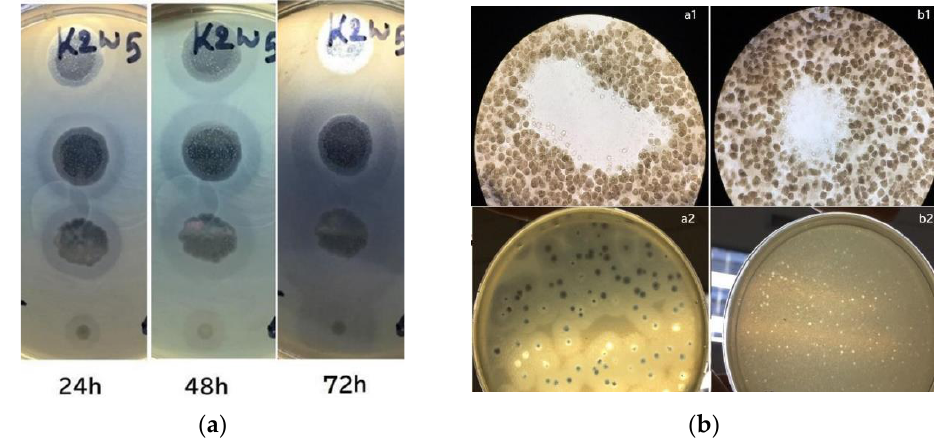
Figure 1. ( a ) Development of plaque halos around k2w5 plaques. The halos continue to expand after the central lysis area ceased to grow; ( b ) Bacteriophage plaques. ( a1 , b1 ) Optical microscope image of bacteriophage plaques and bacterial debris, on bacterial lawn. ( a2 , b2 ) A lawn of K. pneumoniae containing plaques after 4 and 16 h.